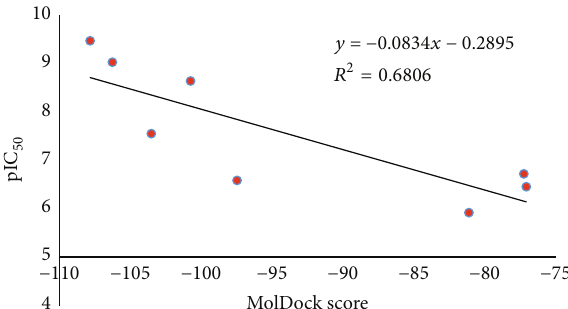
Figure 5: Correlation between binding energy value in MolDock score ( 𝑥 -axis) and experimental pIC 50 values ( 𝑦 -axis) of organophos- phorusgroup.Thecoefficientofdetermination( 𝑅 2 )isalsoindicated.